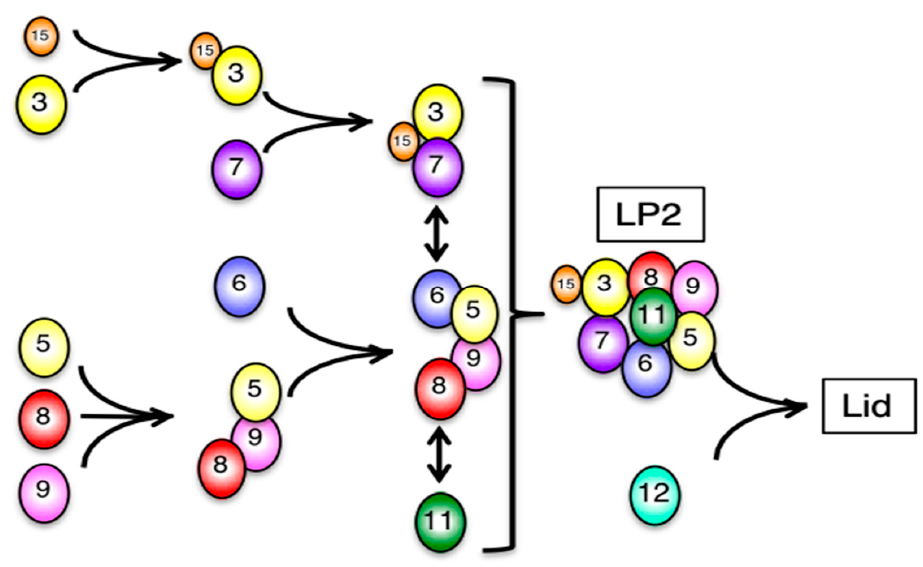
Figure 9. Assembly pathway of the mammalian proteasome lid subcomplex. The assembly of the lid subcomplex starts with the formation of two independent intermediates: Rpn3-15 and Rpn5-8-9. Then, Rpn7 and Rpn6 are incorporated into Rpn3-15 and Rpn5-8-9, forming Rpn3-7-15 and Rpn5-6-8-9, respectively. The Rpn5-6-8-9 complex is a prerequisite for incorporation of Rpn11. Rpn12 is the last subunit to be incorporated.